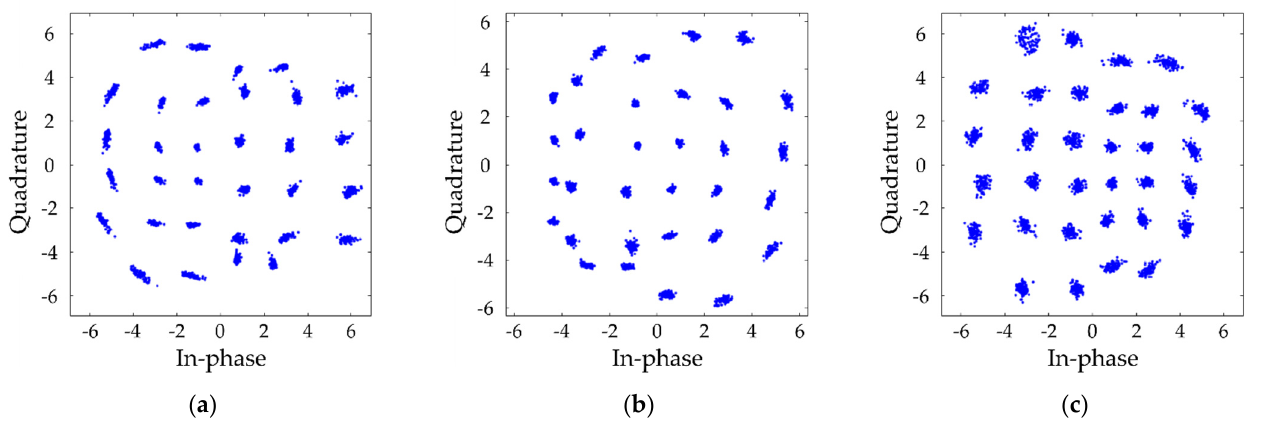
Figure 10. Constellation diagram of SISO LED-to-LED system. ( a ) RtoR, ( b ) GtoG, and ( c ) BtoB when transfer data rate is 27.2, 15.31, and 15.31 kbps, respectively.